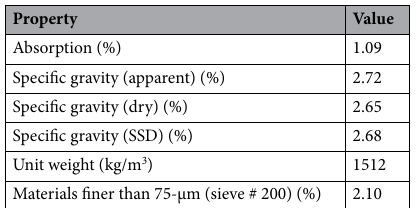
Table 2. Physical and chemical properties of sand.